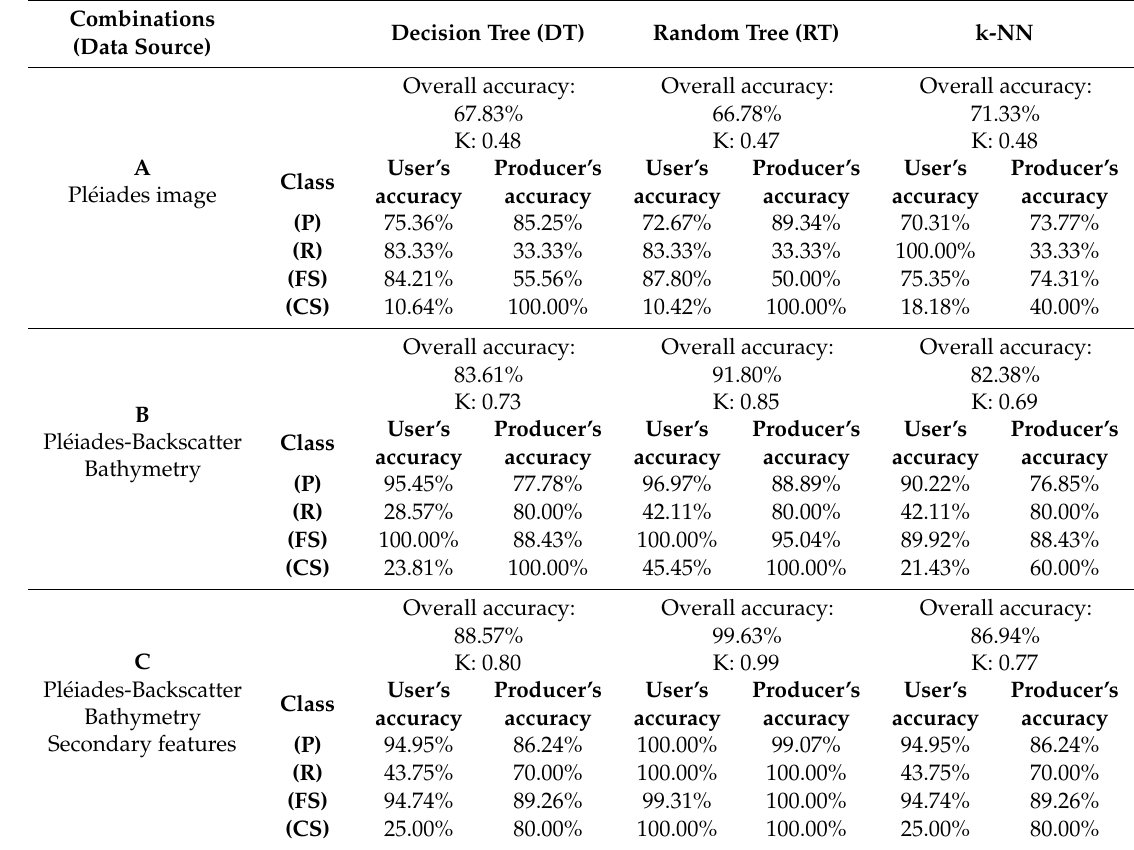
Table 4. Accuracy assessment for the DT, k-NN and RT supervised classification algorithm